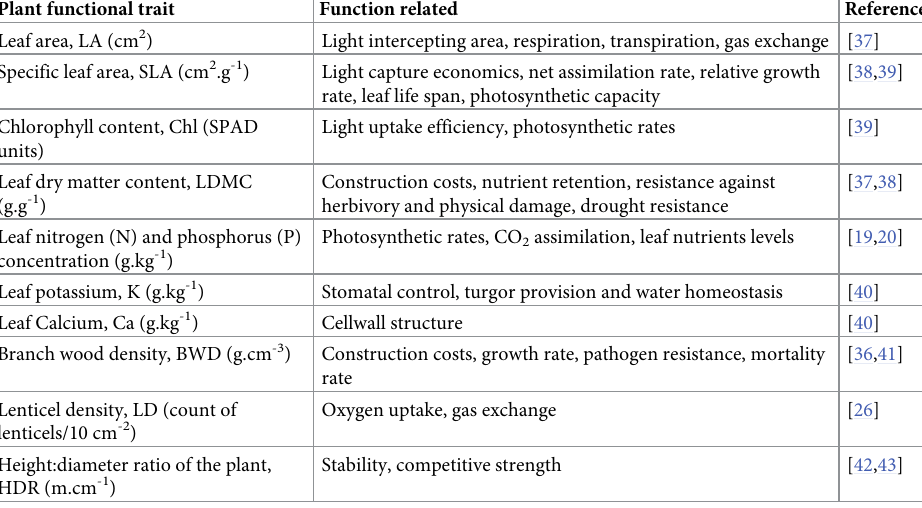
Table 2. Overview of the plant functional traits included in this study, with the trait name, abbreviations, units and their function.